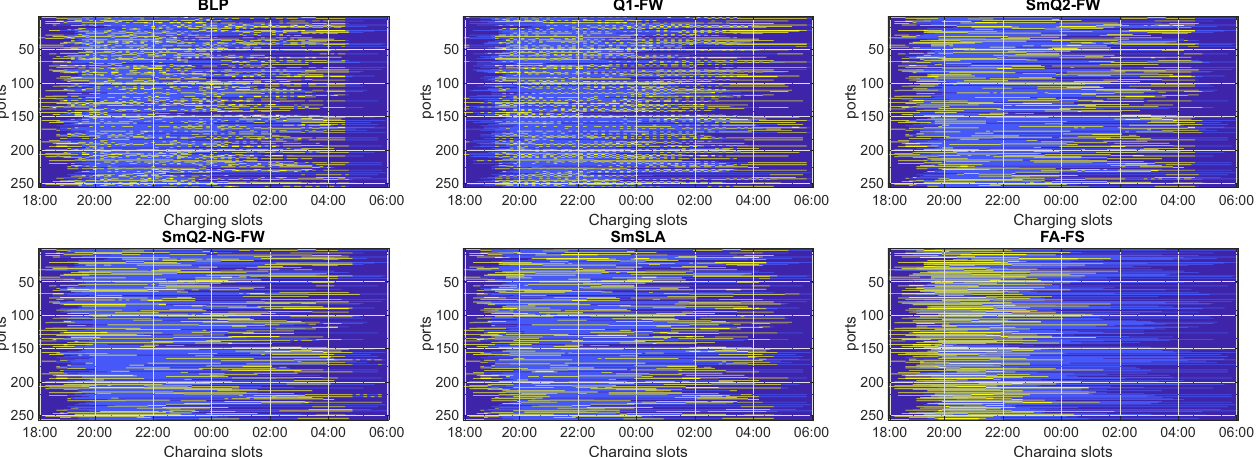
Figure 4. One MC run of charging schedules obtained with the tested algorithms for N = 256 and a constant charging rate. The algorithms were also quantitatively validated using various metrics, which are listed in Tables 2–4. The results obtained for the smallest farm with N = 16 and random charging rates are listed in Table 2. Tables 3 and 4 contain the results obtained for the largest farm with constant and random charging rates,